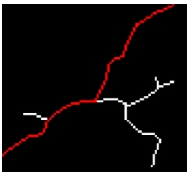
Figure 13. Main crack skeleton.